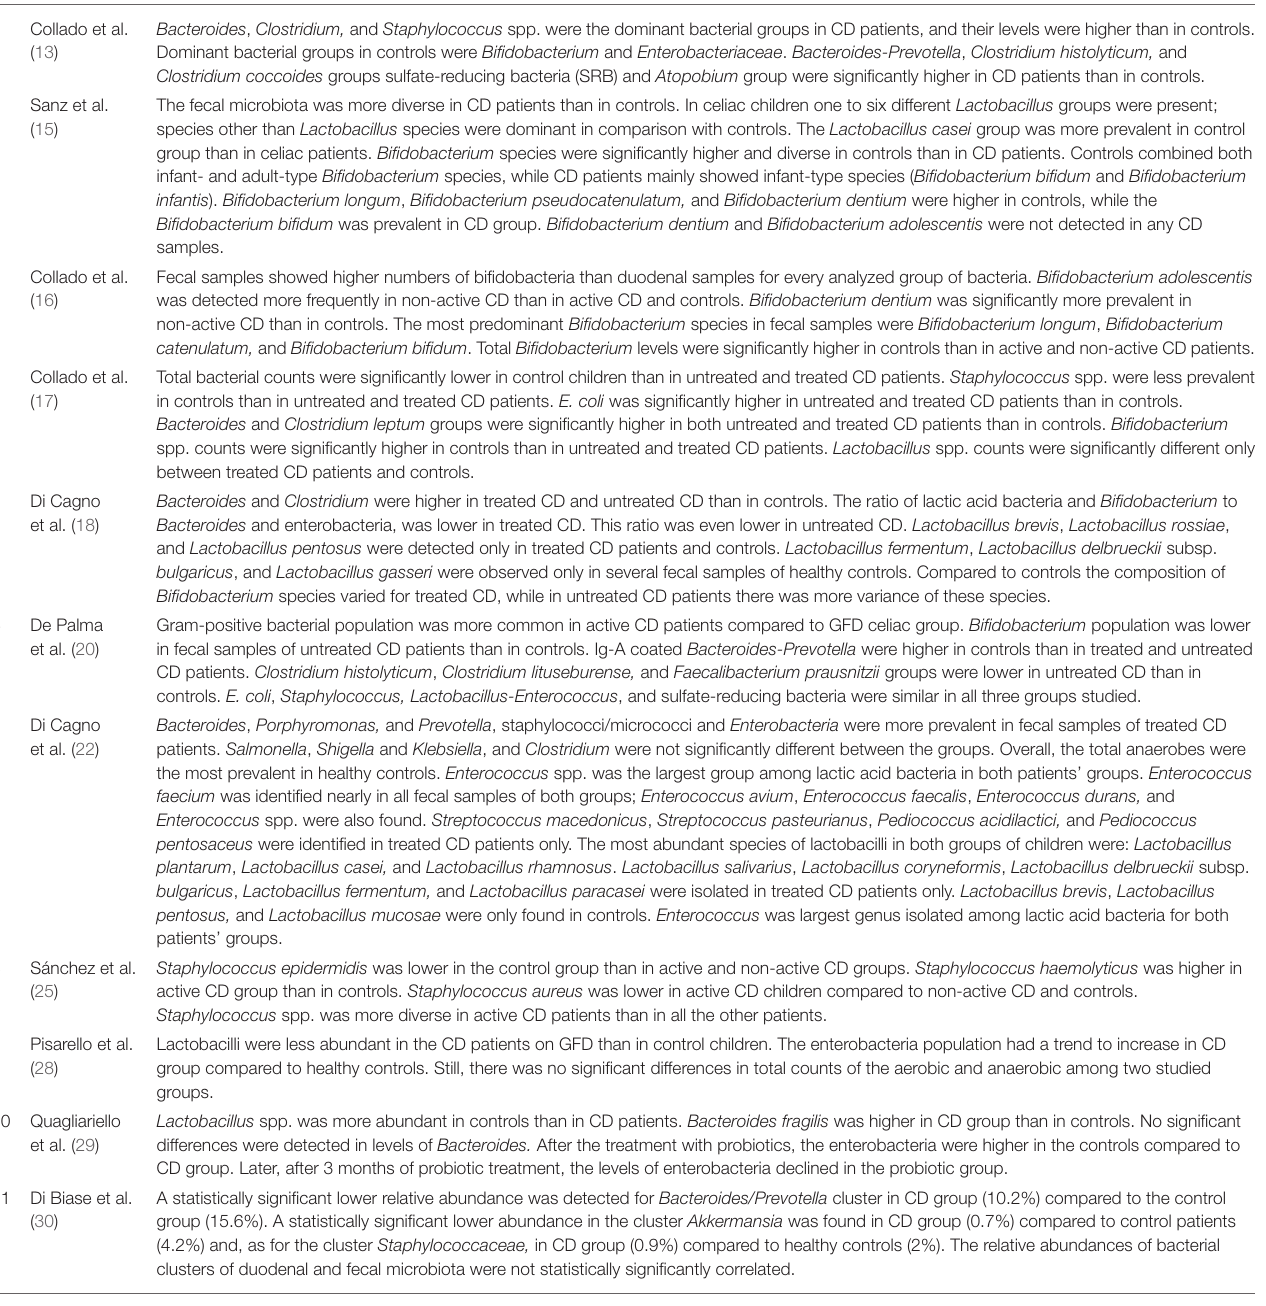
TABLE 4 | Main findings from the studies analyzing the fecal